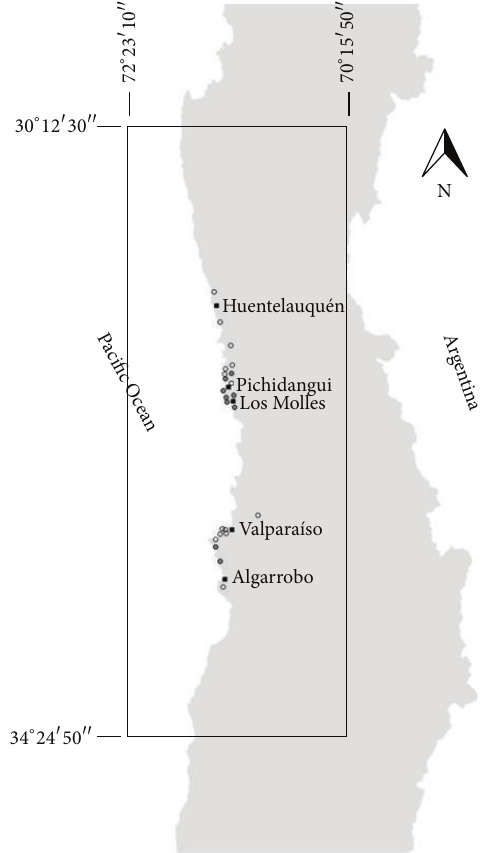
Figure 1: Area of study. The area of study covers the coastal areas of Central Chile. Historical presence records for P. splendens go from the coastal village of Huentulauqu´en to the beach resort of Algarrobo. Dots respresent recorded presence for the species; filled dots are those for which we found in-site current presence of individuals. The black rectangle indicates the area magnified in the binary distibution maps shown in Figure 2.